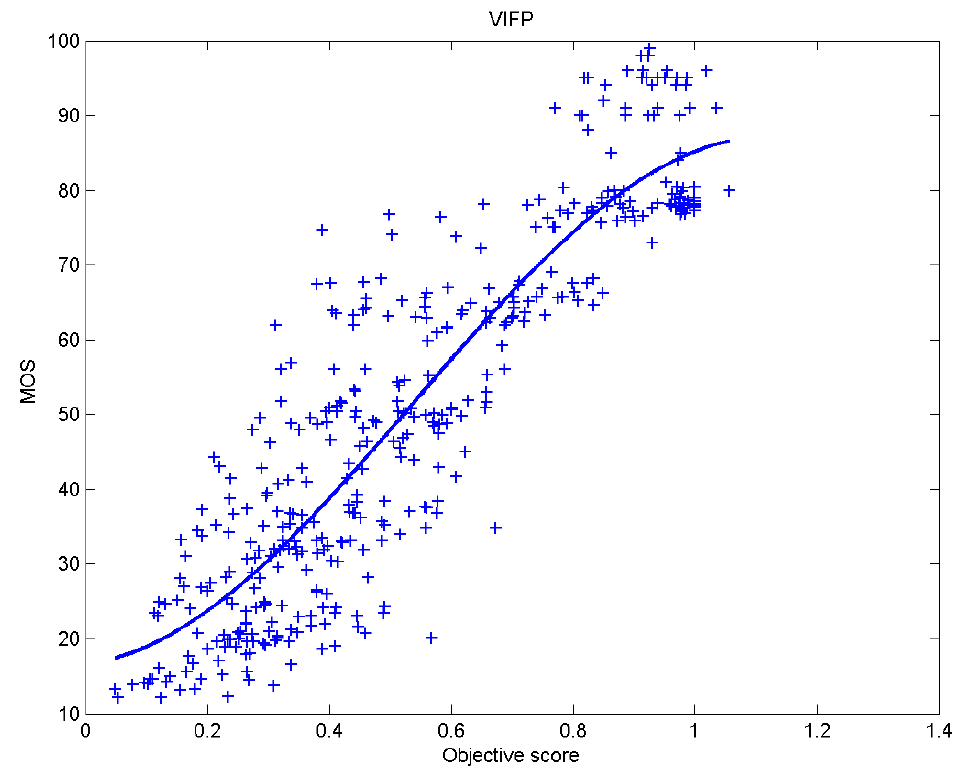
Figure 21. Scatter plots of the subjective scores (MOS) vs. VIFP.